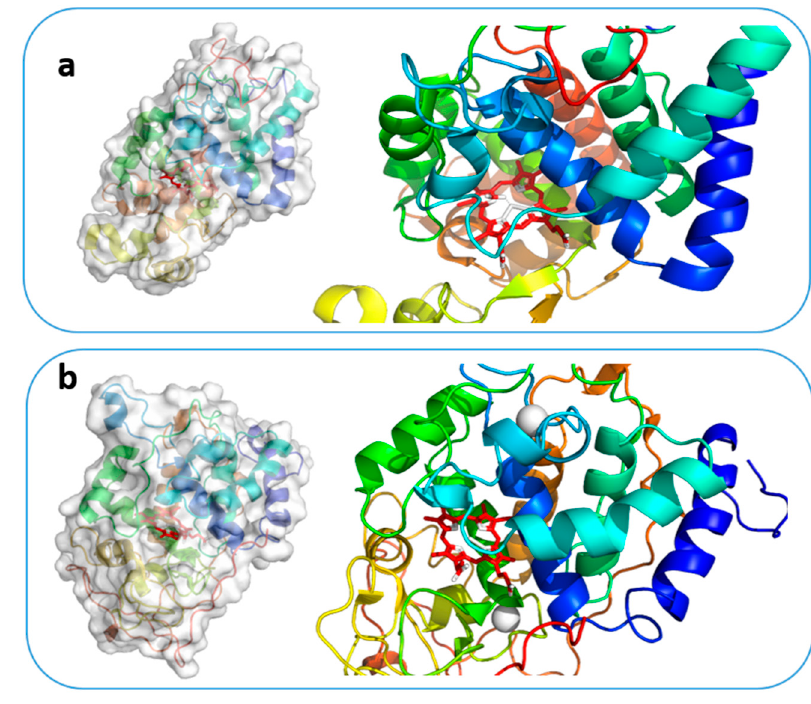
Figure 1. Molecular structure of HRP ( a ) and LiP ( b ) (left) with detailed view of their active sites. The heme-unit is highlighted with red color. The image has been produced in this work, applying PyMol software [31].